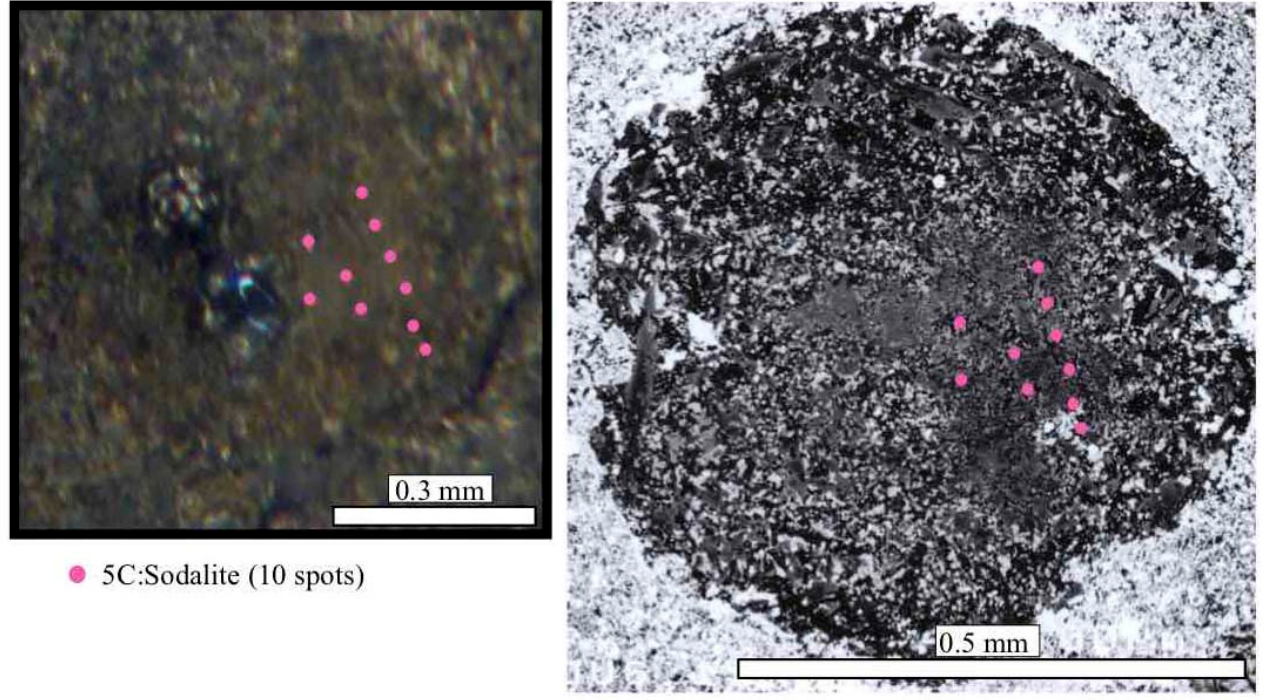
Figure 8. Optical view and BSE image of UC-02 showing the laser shot locations. The number of laser spots is ten shots for the 5C sodalite phase (pink).